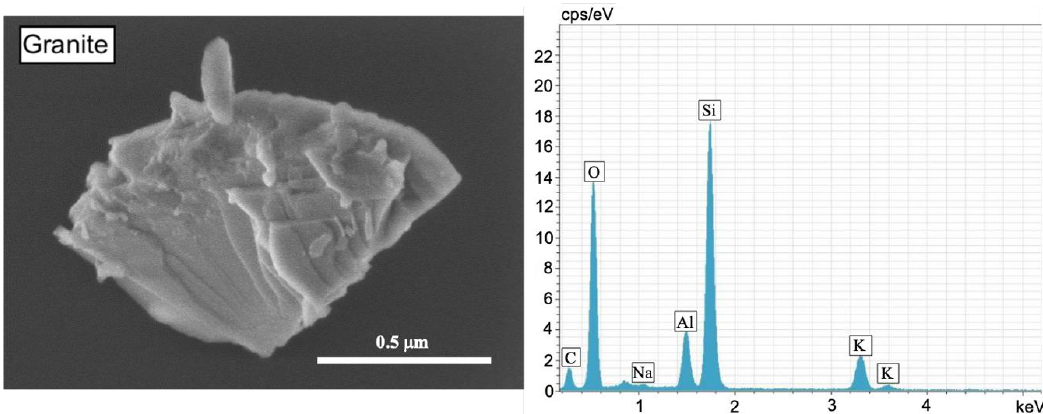
Figure 4. Secondary electron images of airborne grinding particles and energy dispersive spectroscopy